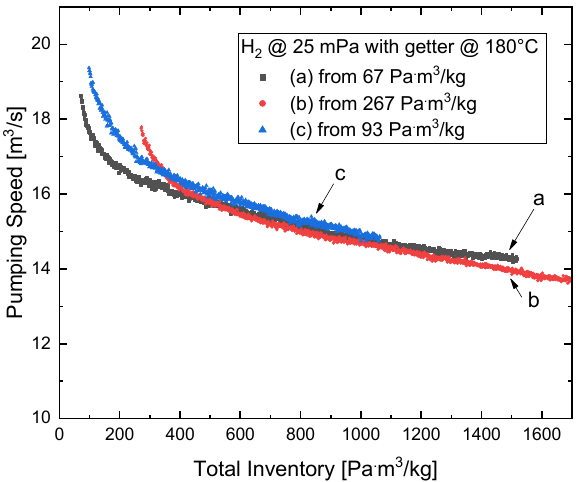
Figure 16. Pumping speed curves at comparable conditions, but starting at different inventories, which remain from differently deep previous regenerations.